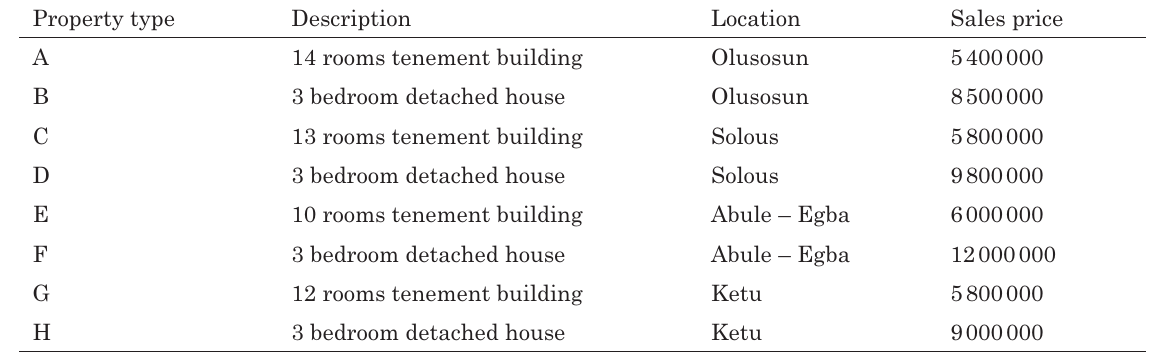
Table 5. Description of property Property